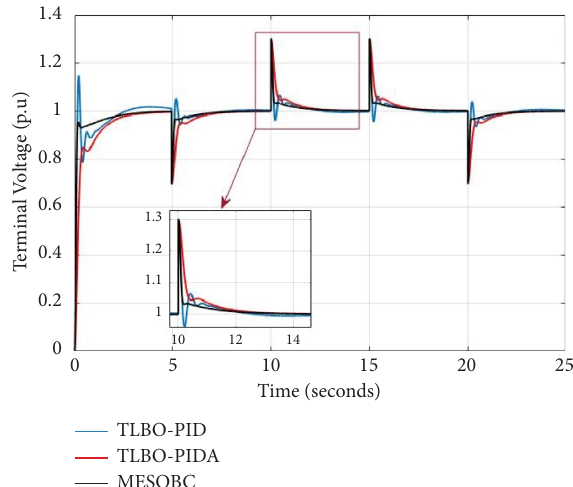
Figure 8: Response of terminal voltage under − 50% parametric uncertainties in ( T